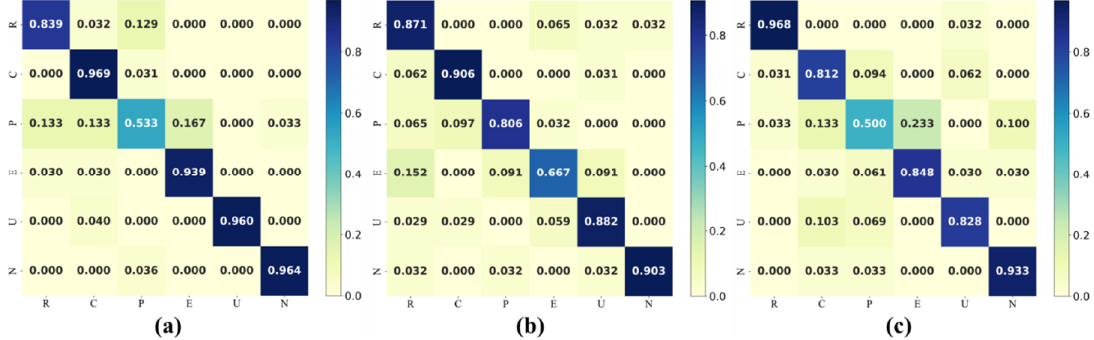
Figure 5. Confusion matrix of three different partition methods. ( a ) Block, ( b ) Grid, ( c ) Object. (R—